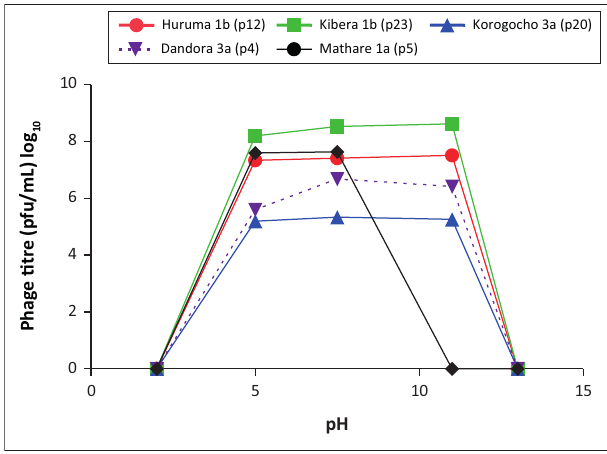
FIGURE 2: Effect of pH on phages isolated in Nairobi County, Kenya, July 2019 to December 2020. Phages were named based on source and phage strain number